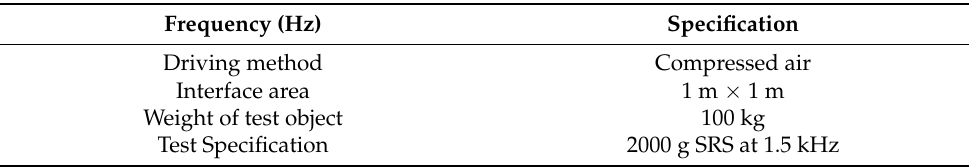
Table 12. Specification of vertical pyro-shock test machine.